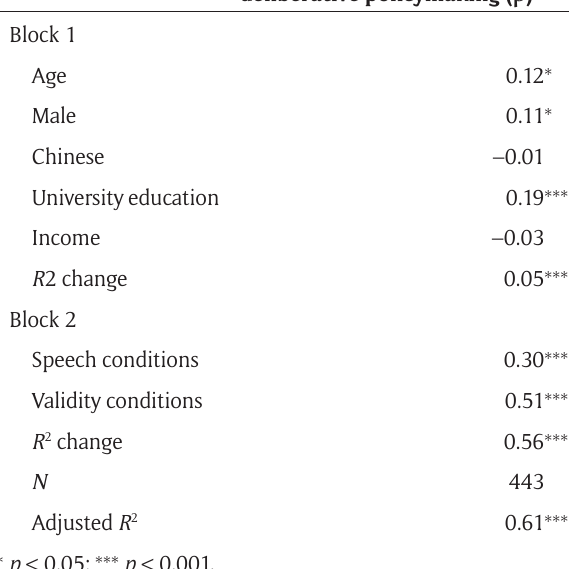
Table 3: Effects of speech and validity conditions on general support for deliberative